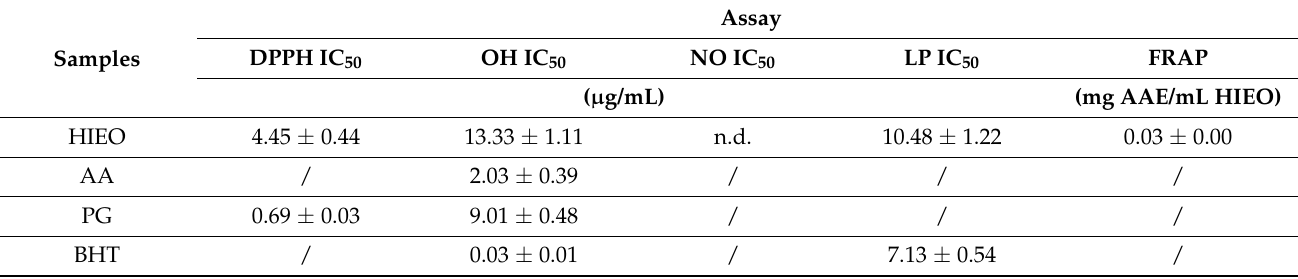
Table 2. Antioxidant potential of H. italicum essential oil and positive control substances.